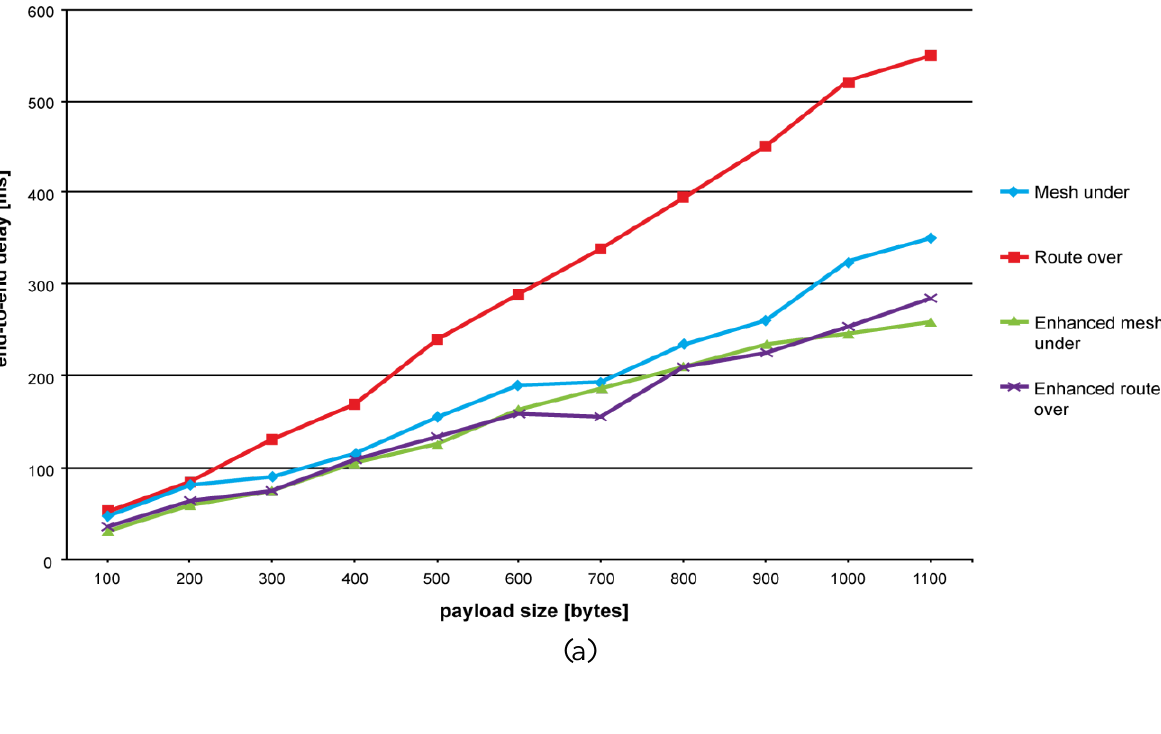
Figure 5. End-to-end delay time evolution. The number of retransmissions is lower in controlled mesh under than in mesh under, resulting in a better end-to-end delay time trend. (a) End-to-end delay time for a two hops network. (b) End-to-end delay time for a three hops network. (c) End-to-end delay time for a four hops